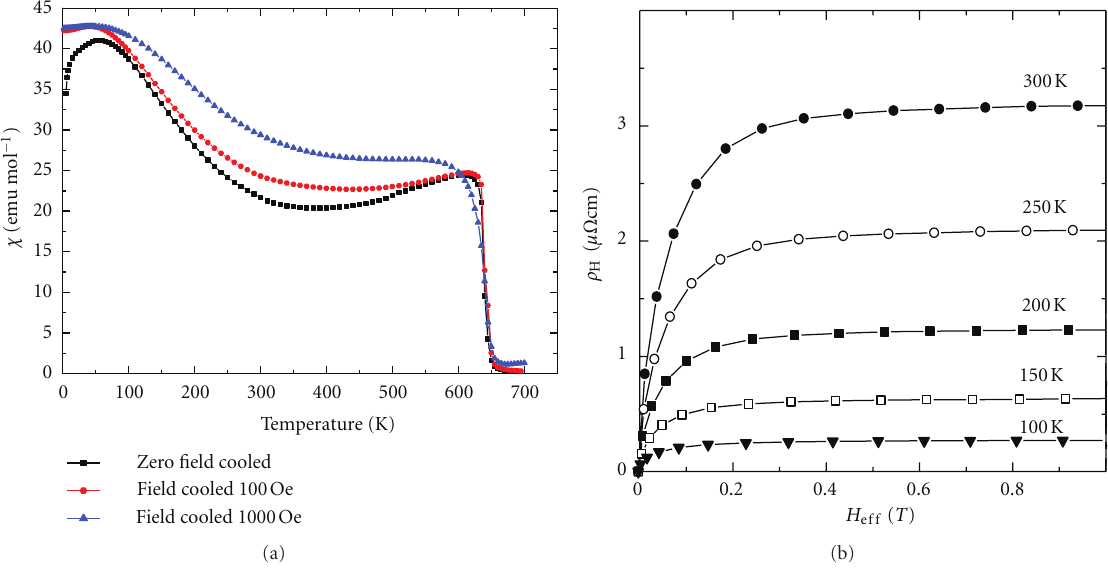
Figure 10: (a) Zero-field-cooled and field-cooled magnetic susceptibility, χ , of powdered Fe 3 Sn 2 . Upon cooling below the Curie temperature, T C ≈ 650K, the moments order ferromagnetically along the hexagonal c -axis. Below T ≈ 350K, the moments then rotate into the ab -plane. During this transition, the moments become noncollinear, shown by the gradual increase in χ . The broad maximum at T ≈ 80K indicates a transition to a spin glass state which coexists with an ordered ferromagnetic moment now lying largely in the ab -plane, taken from [13]. (b) Field-dependence of ρ xy at various temperatures. The dependency is similar to that observed for M . The large room temperature saturated value of 3.2 μ Ω cm demonstrates the potential for geometrically frustrated ferromagnets as materials for spintronics devices, taken from